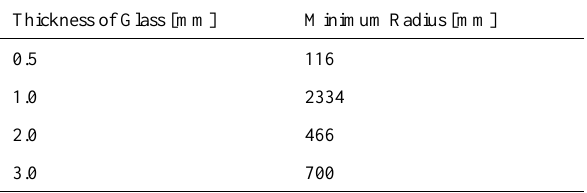
Table 1: Minimum radii depending on thickness of